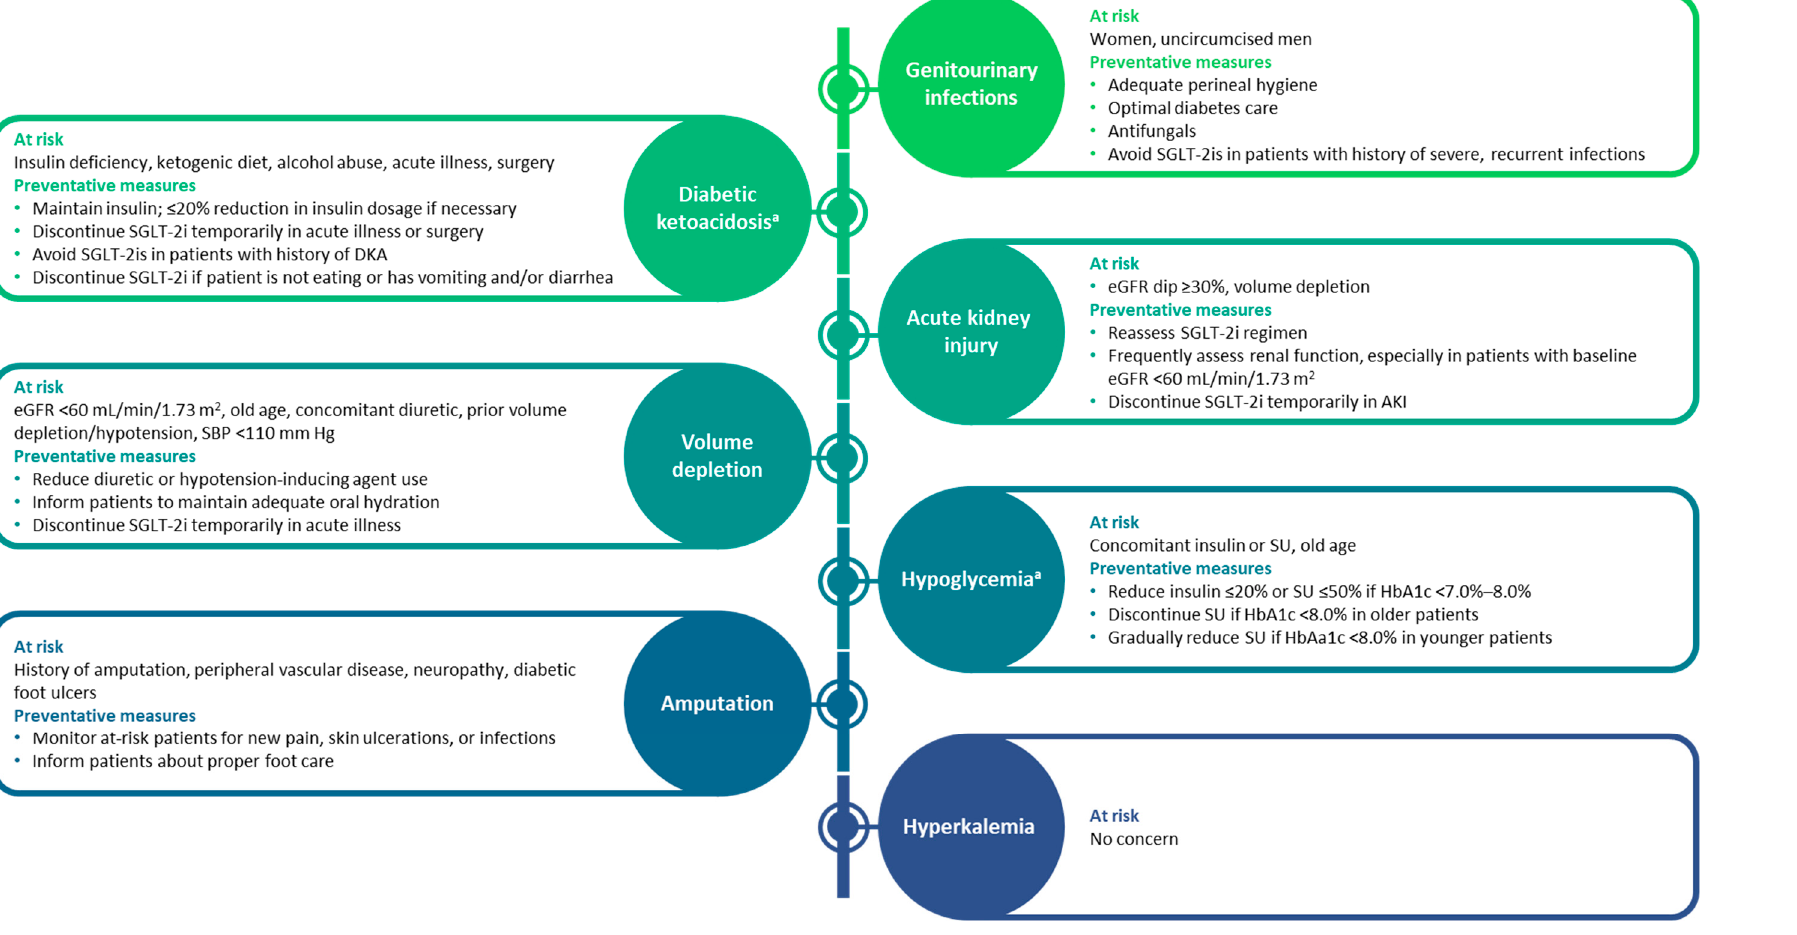
Figure 3. Adverse events associated with SGLT-2is and proposed preventative measures [36,37,40]. a Occurs only in patients with type 2 diabetes. AKI, acute kidney injury; DKA, diabetic ketoacidosis; eGFR, estimated glomerular filtration rate; HbA1c, glycated hemoglobin; SBP, systolic blood pressure; SGLT-2i, sodium-glucose cotransporter-2 inhibitor; SU, sulfonylurea.